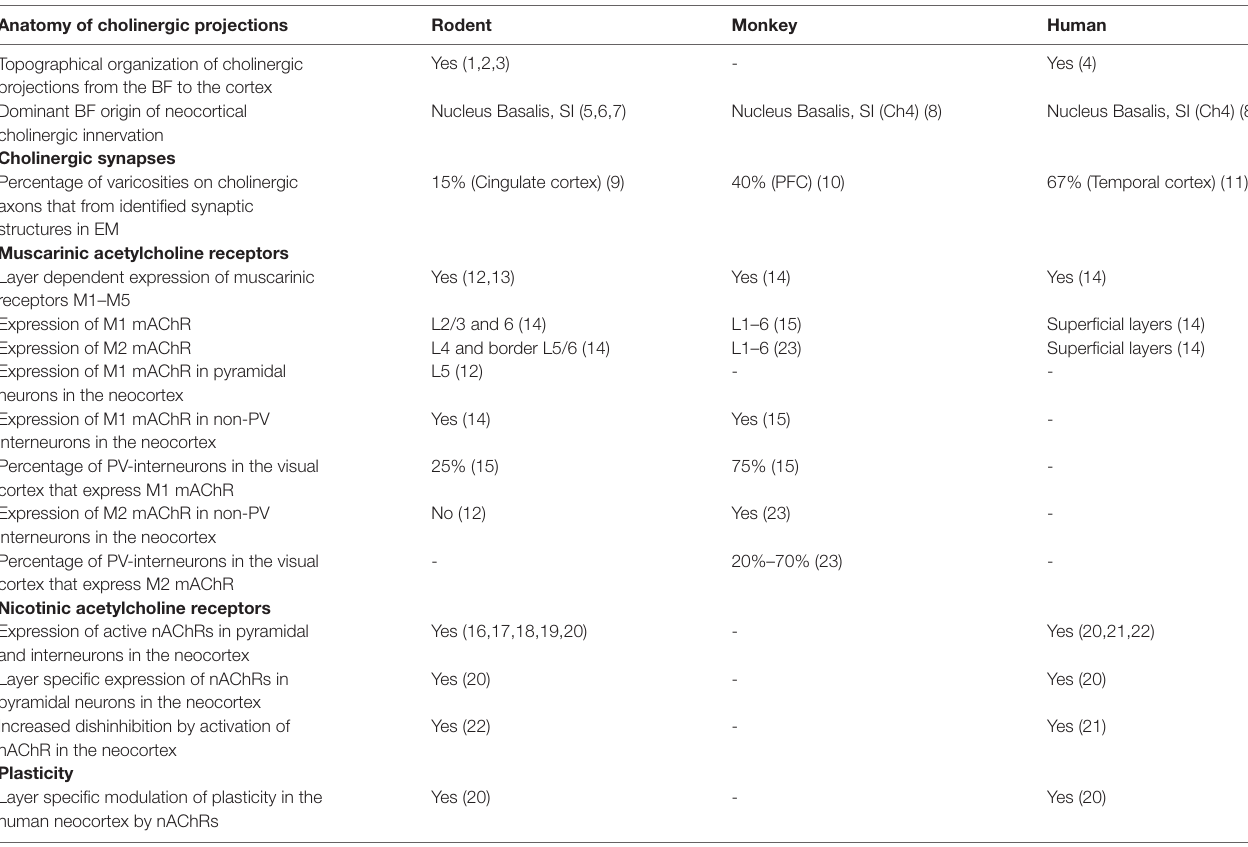
TABLE 1 | Cross-species comparison of the neocortical cholinergic